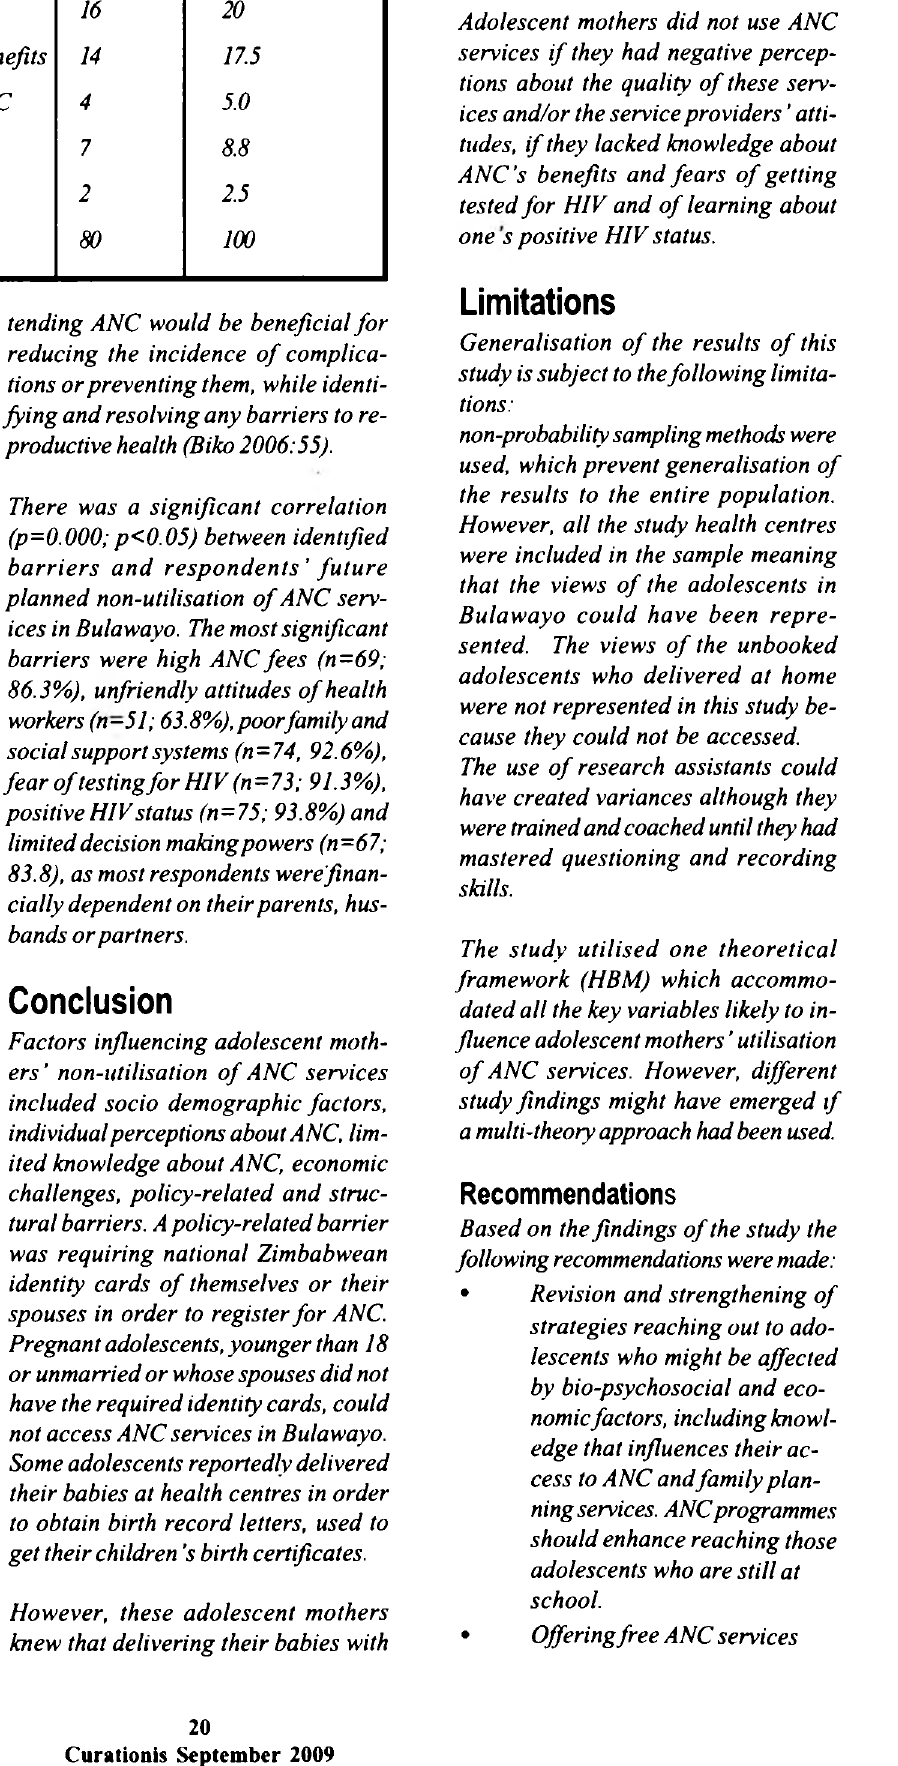
Table 3: Reasons for not attending ANC with last pregnancies (n=80) Reason n % Fear o f disclosing the pregnancy Feeling well and the baby was